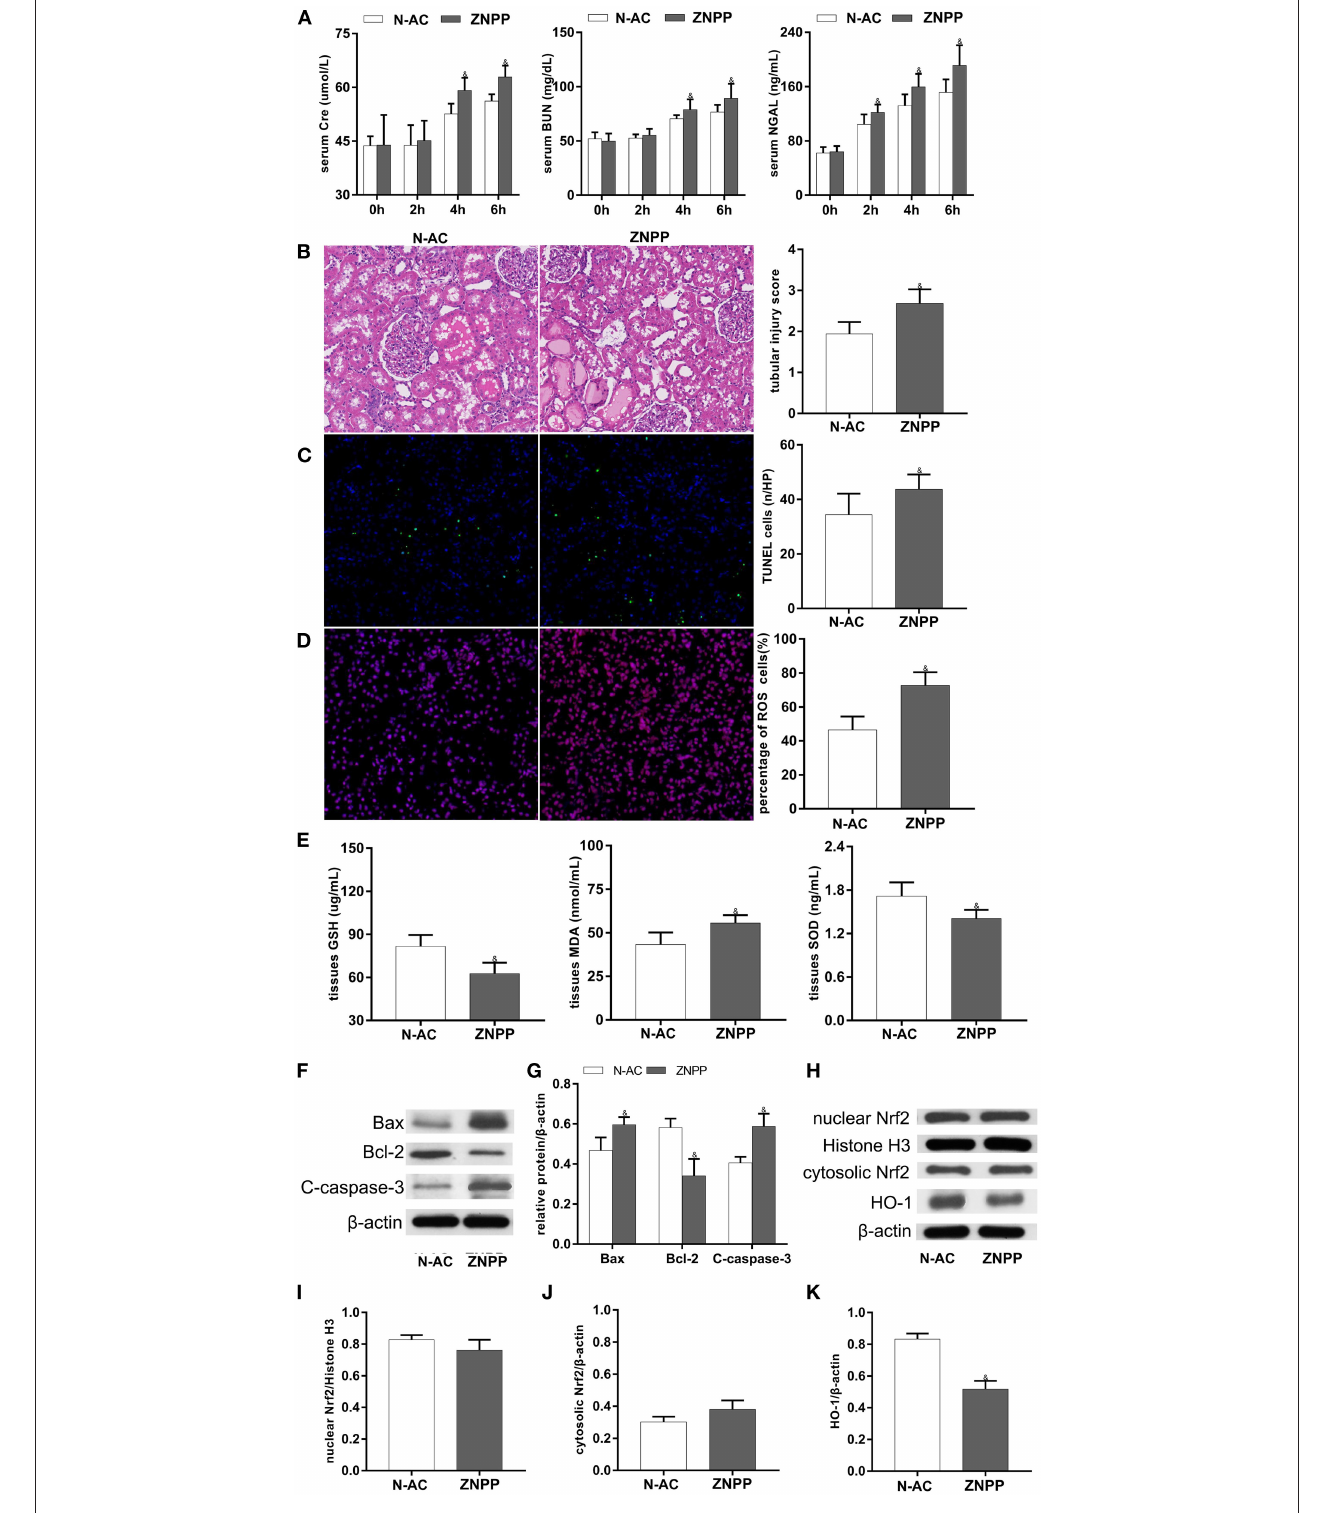
FIGURE 7 | The participation of HO-1 in the protective effects of N-AC after CPR in the kidney was clarified by using the specific HO-1 inhibitor, ZnPP. (A) The dynamic changes of Scr, BUN and NGAL after ROSC. (B) HE staining determines pathological changes in the kidney. (C) TUNEL staining detects the numbers